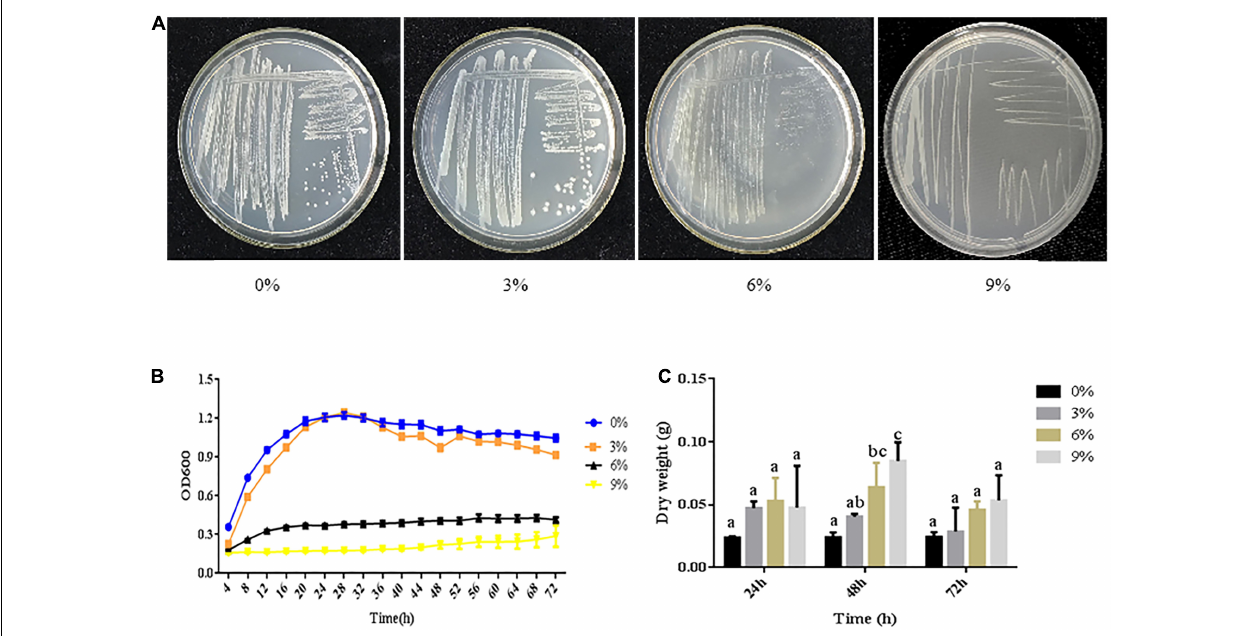
FIGURE 1 | Growth of R. aquatilis JZ-GX1 in media with different salt concentrations. (A) Images of culture plates. (B) Growth curves. (C) Cell dry weights. The vertical bars represent the standard deviations of the averages. One-way ANOVA was performed, and Duncan’s post hoc test was applied. Different letters indicate significant differences ( P < 0.05) among the